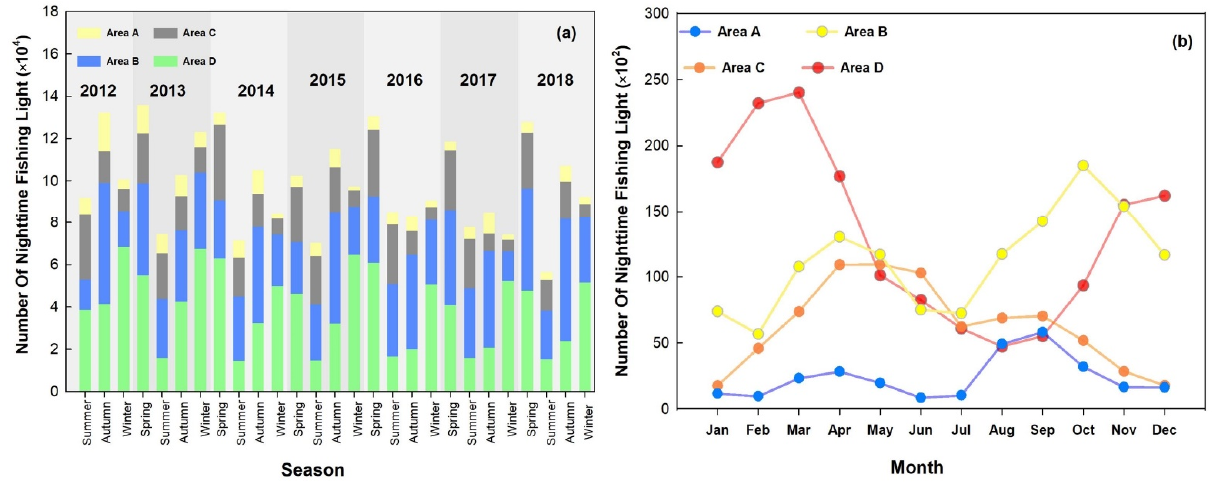
Figure 11. The number of nighttime fishing light in four selected subregions ( a ) seasonal results ( b ) monthly results.